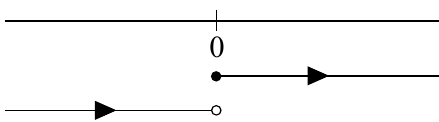
Figure 2. Linear order induced by the fractal structure Γ in R